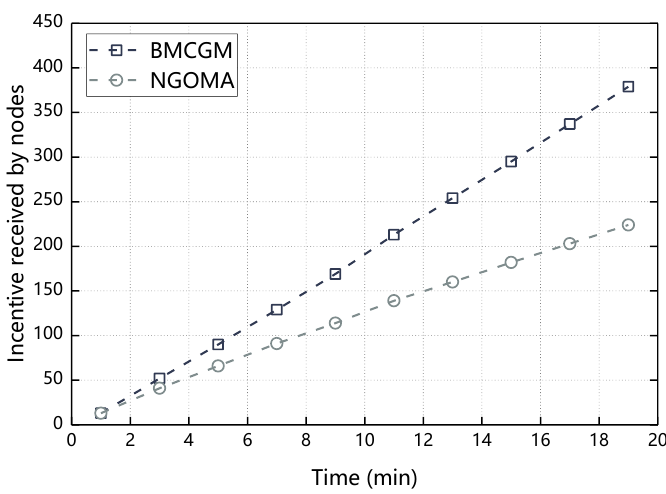
Figure 10. Incentive received by nodes with respect to time.